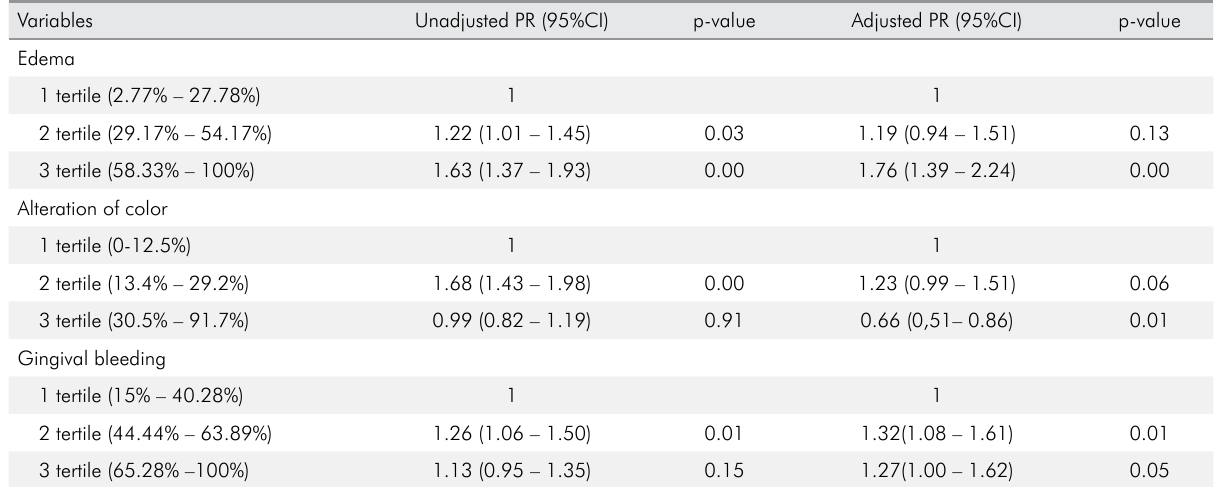
Table 3. Poisson regression analyses of the association between clinical signs of gingivitis in the anterior region and overall CPQ 11-14